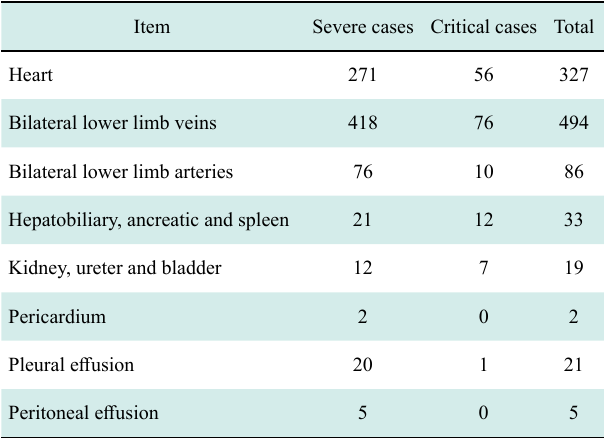
Table 1 Bedside ultrasound examinations of COVID-19 confirmed patients